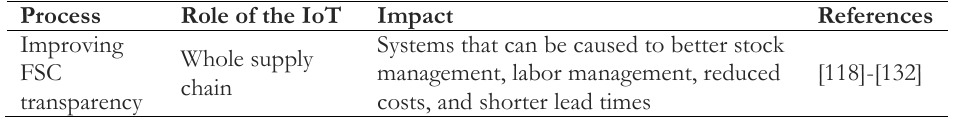
Table 9. Application of the IoT in the food supply chain transparency in the food supply